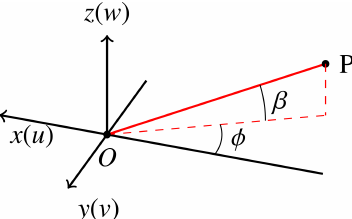
Figure 6. The typical coordinate system for simulating an upstream-looking nacelle lidar. P denotes an arbitrary point along the lidar beam